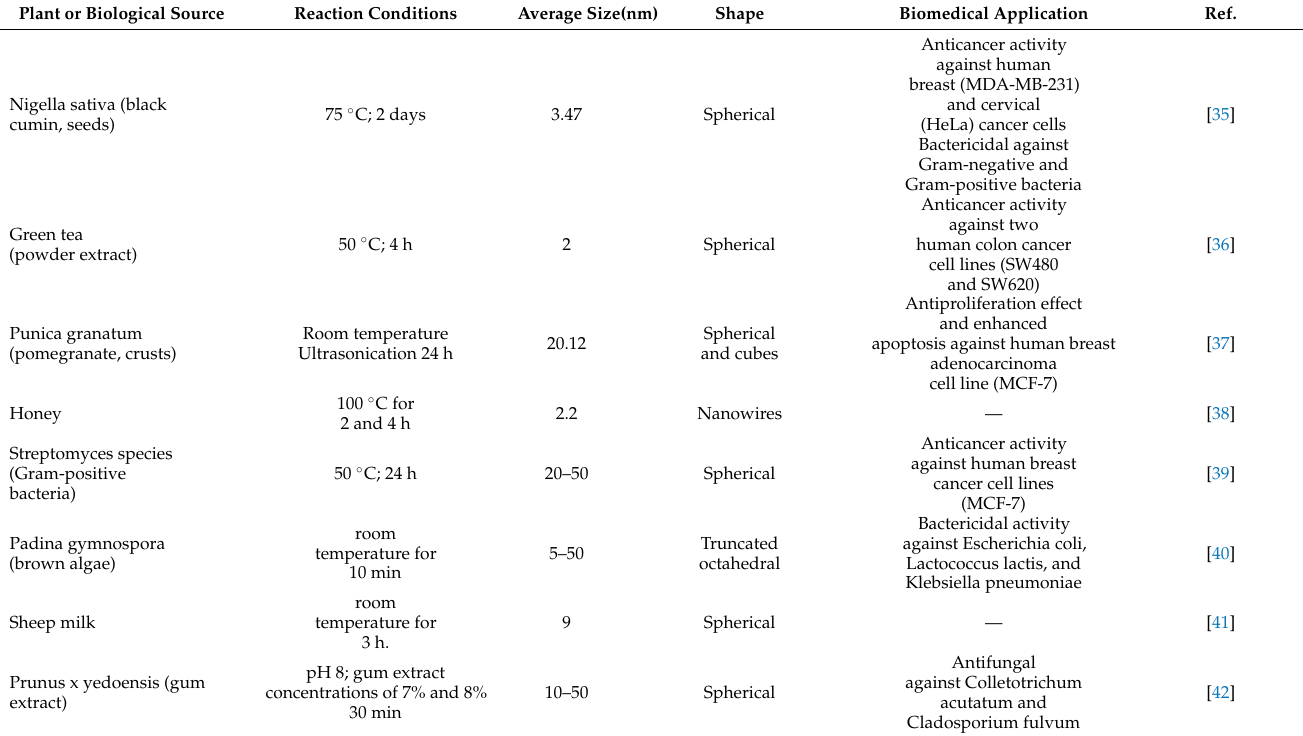
Table 4. Synthesis of AgNPs by using different